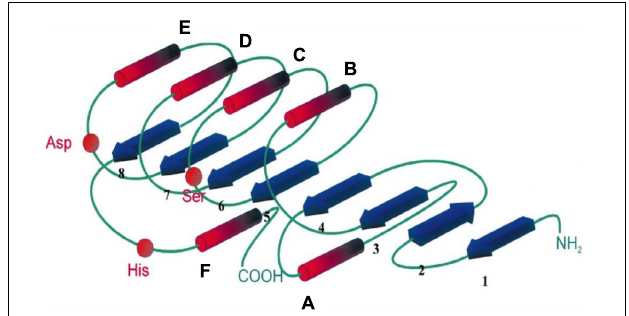
FIGURE 2 | Schematic of the canonical α / β hydrolase fold. The filaments forming the structure in β -pleated sheet (1–8) are indicated by blue arrows and the structures in α -helices (A–F) are indicated by red columns. The relative positions of the amino acids of the catalytic triad are indicated by red beads. The amino-terminal region is indicated by NH2 at the beginning of the chain, and by COOH for the carboxy-terminal region for the end of the chain. The figure was reprinted with permission, from Bornscheuer (2002).